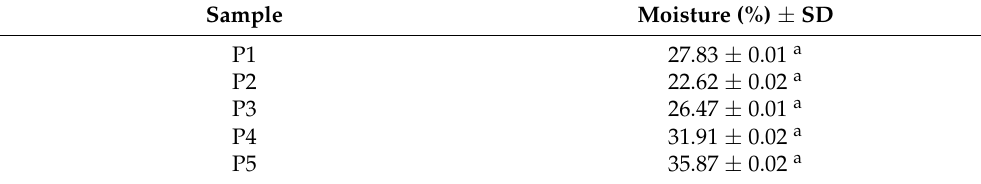
Table 2. The moisture